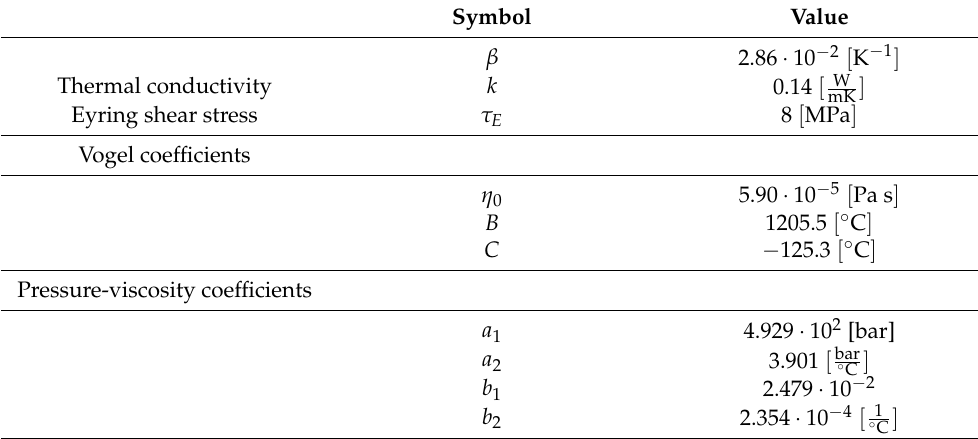
Table 1. Coefficients of the 75W90